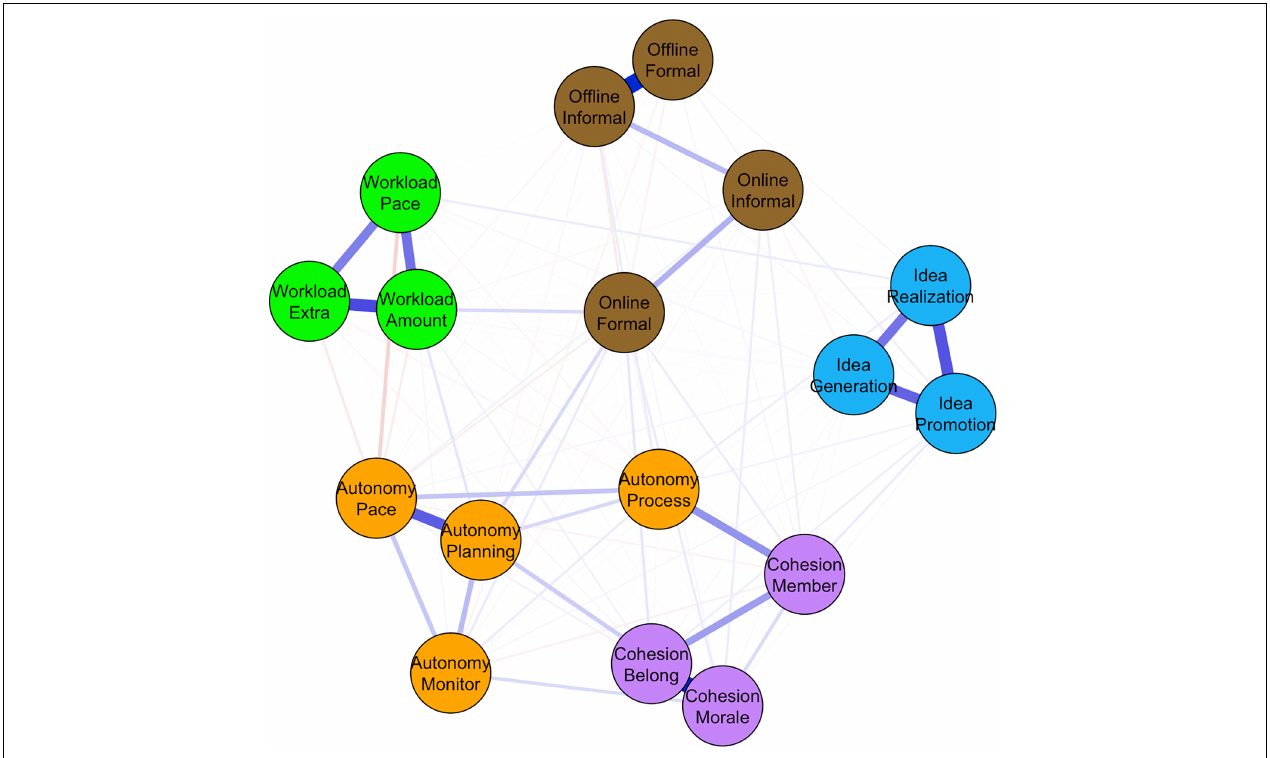
FIGURE 1 | Network of employee perceptions, attitudes, and behaviors related to innovative work behavior. Blue edges represent positive relationships, red edges represent negative relationships. The thickness is proportional to the magnitude of the